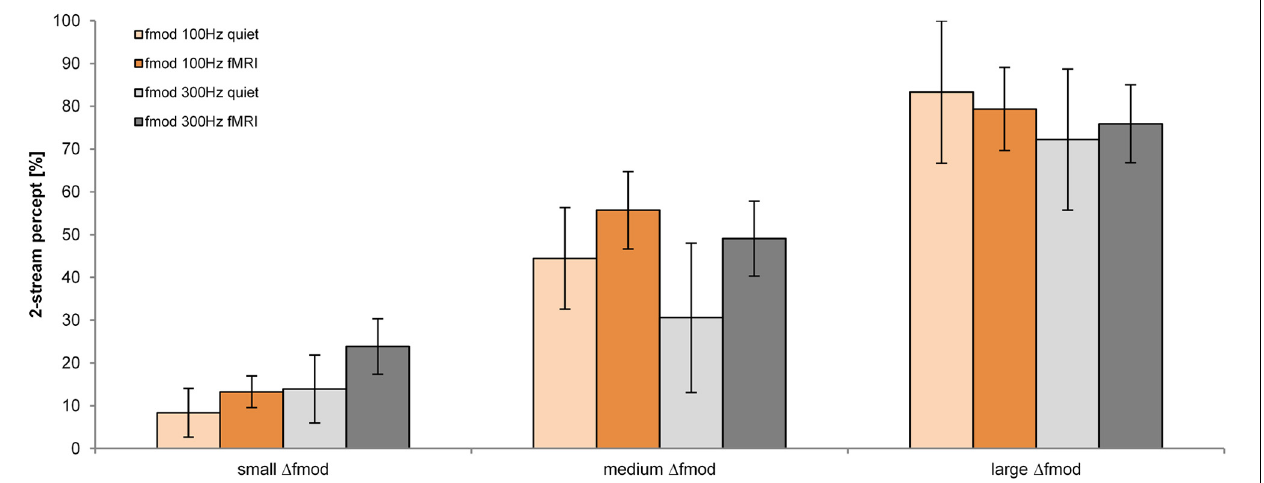
FIGURE 3 | Proportions of a 2-stream percept (mean and s.e.m.) are shown for the f mod A of 100Hz (orange) and 300Hz (gray) for the measurements in quiet (lighter coloring: n = 6) and during fMRI (darker coloring: n = 13) for all (cid:2) f mod conditions.